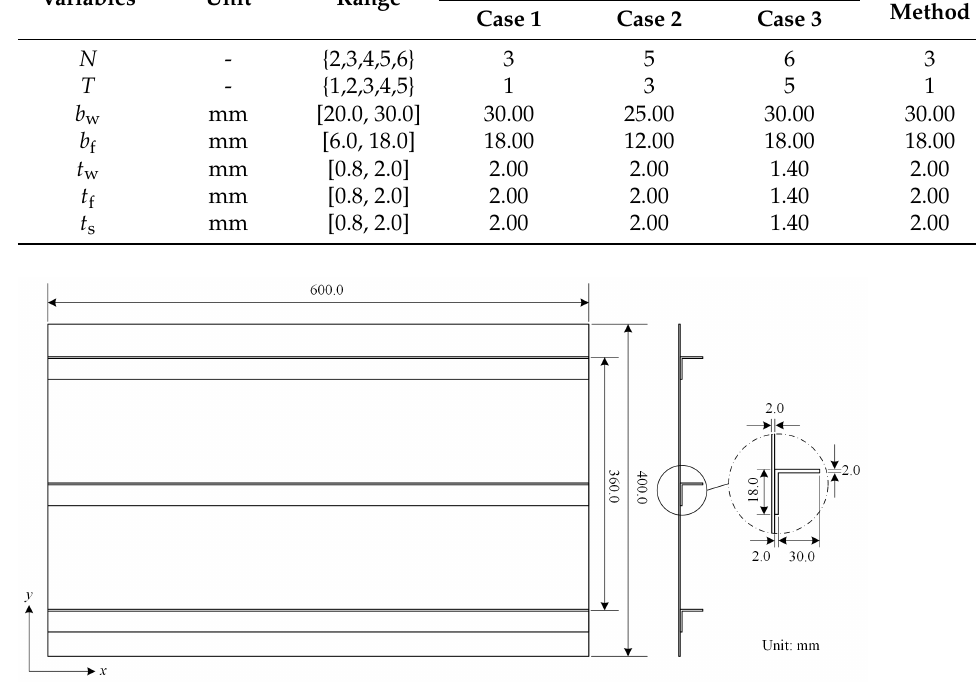
Figure 9. Initial geometry model of Case 1. The stiffened plate is subject to static and dynamic load cases, respectively, and is simply supported on four sides, as shown in Figure 10.